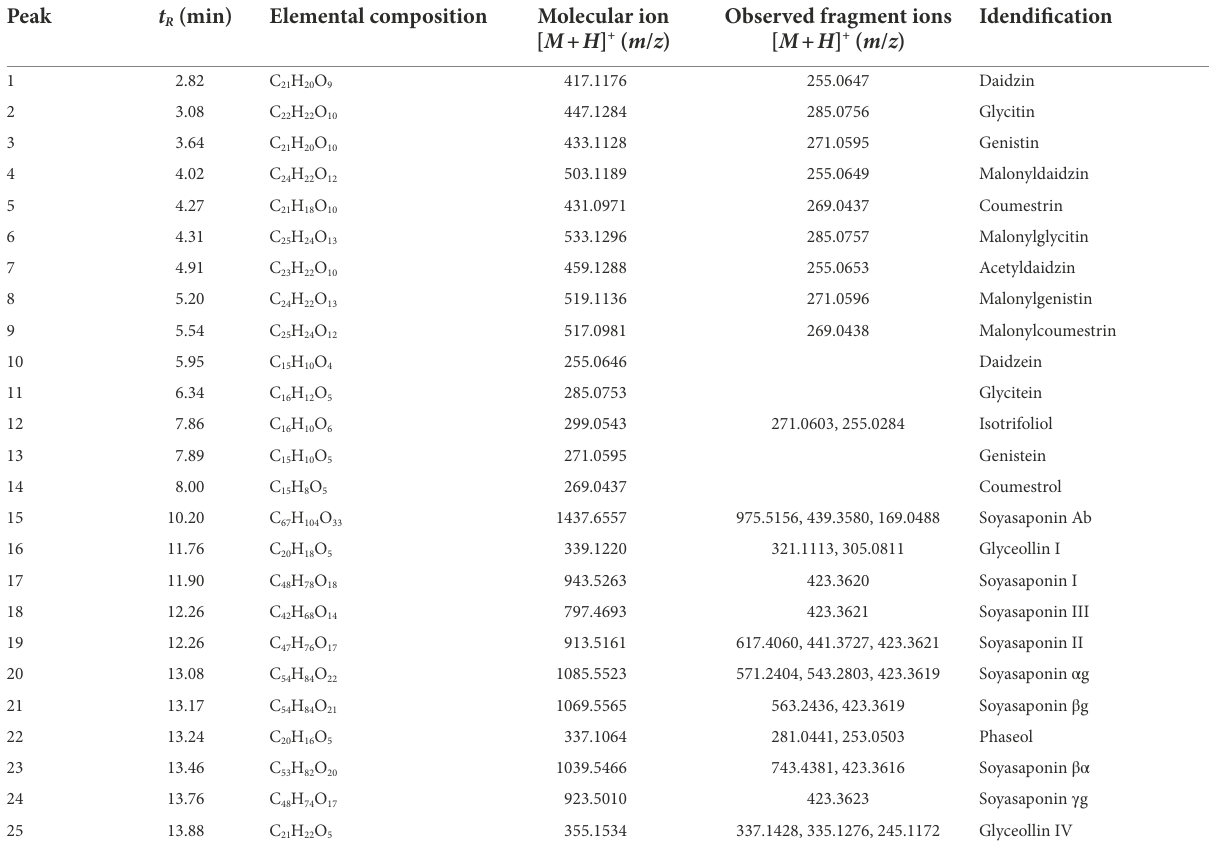
TABLE 2 Peak assignments of secondary metabolites in soybean roots by UPLC–ESI-TOF/MS. Peak t R (min) Elemental